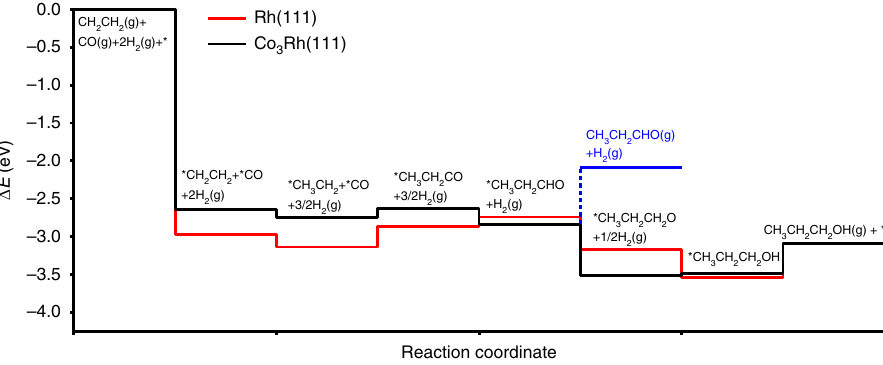
Fig. 5 DFT calculations of reaction pathways on Rh(111) and Co 3 Rh(111). DFT calculated energy change ( Δ E ) for hydroformylation into propanal and further hydrogenation into 1-propanol on monometallic Rh and bimetallic RhCo